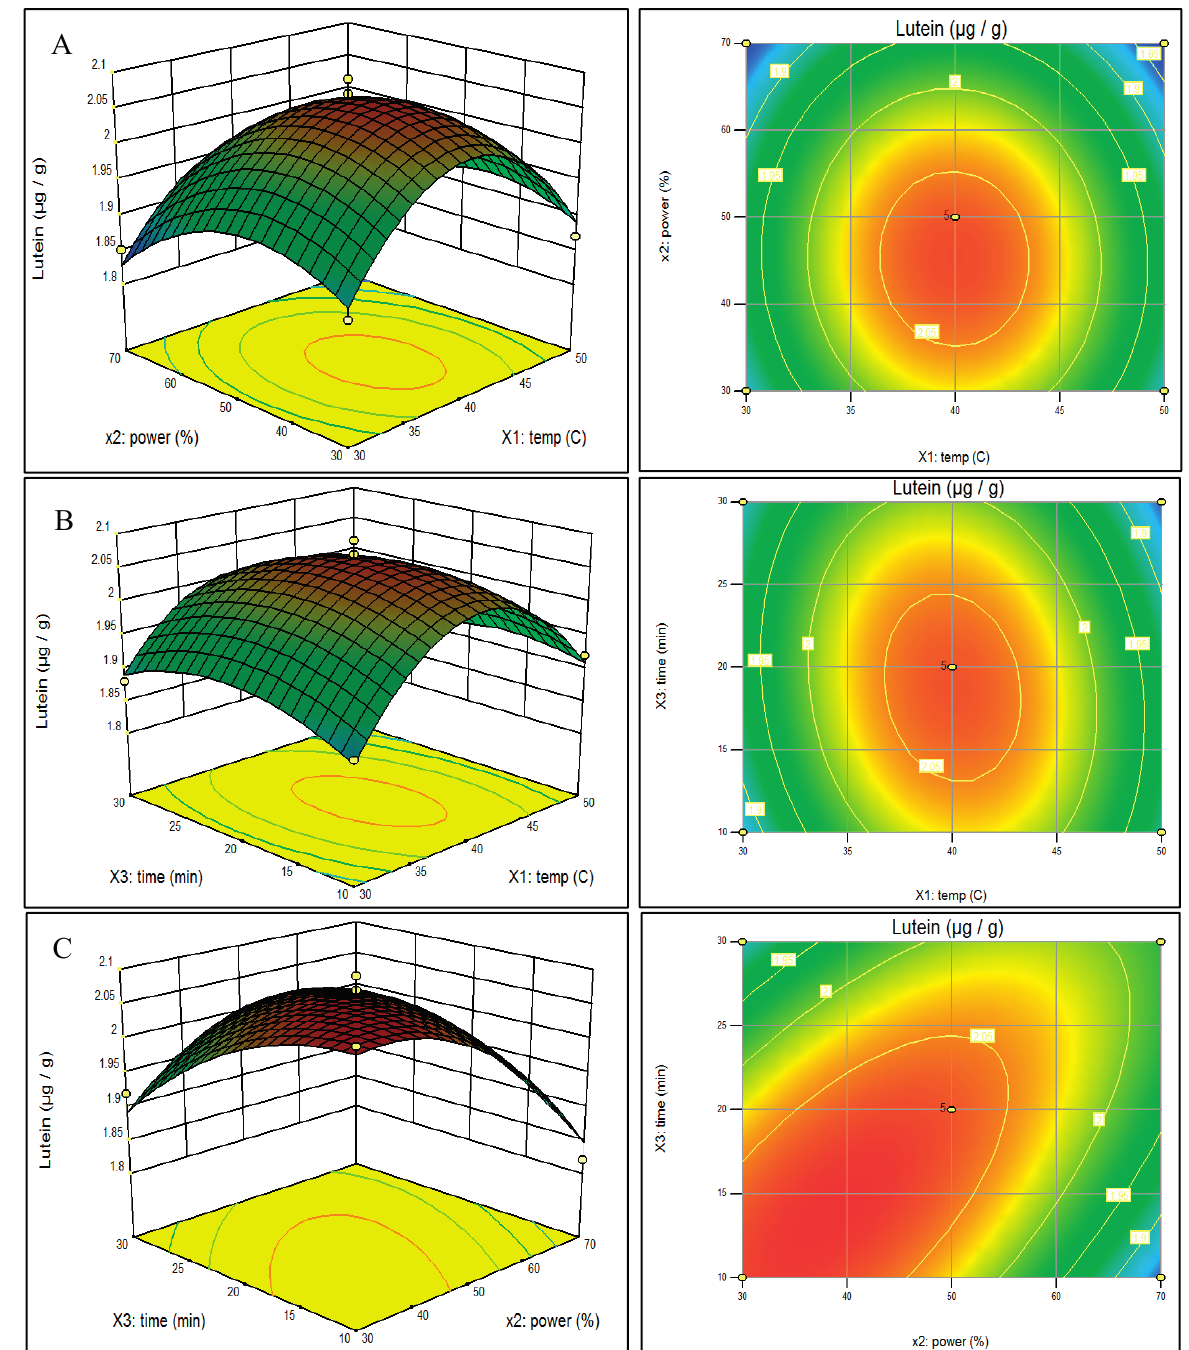
Figure 1. Response surface model plot showing the effects of independent variables on Lutein content: panel A temperature and power; panel B temperature and time; and panel C power and